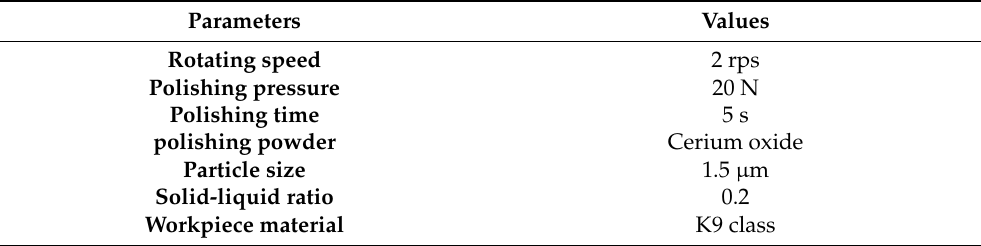
Table 2. Experimental parameters.